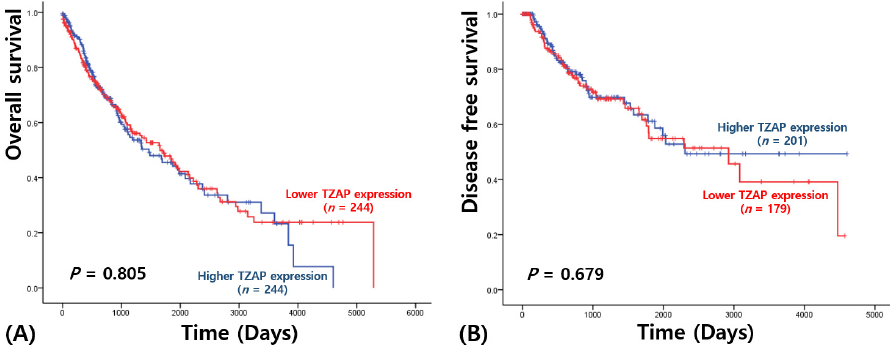
Figure 3. Survival analysis in squamous cell carcinoma: ( A ) overall survival; ( B ) disease-free sur- vival.